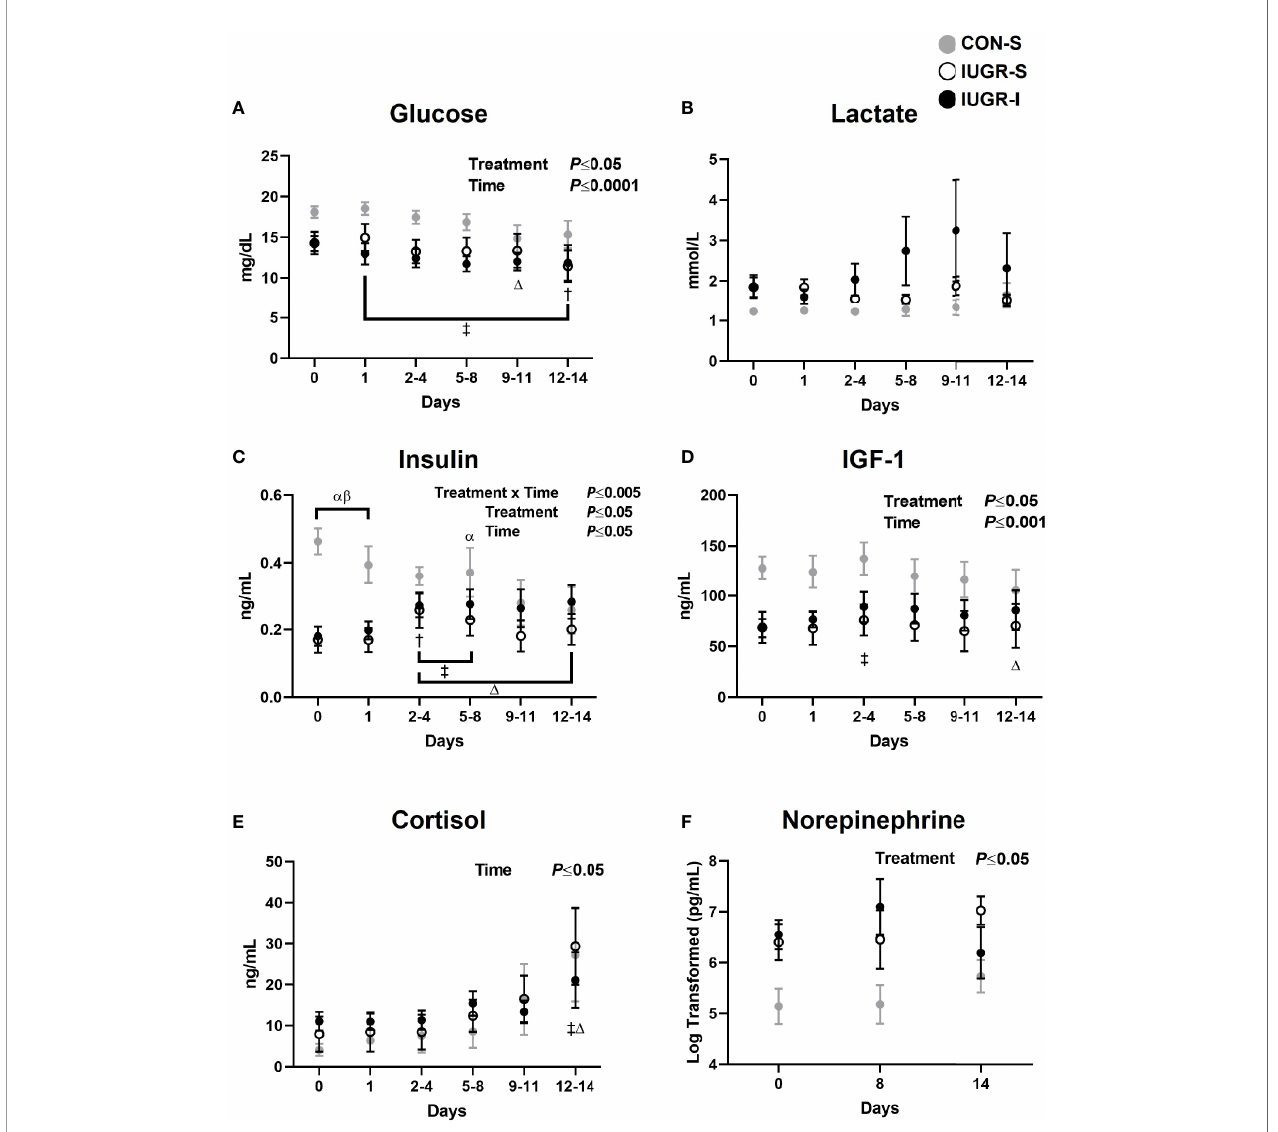
FIGURE 3 | Fetal arterial plasma hormone values. Fetal arterial plasma (A) glucose, (B) lactate, (C) insulin, (D) IGF-1, (E) cortisol, and (F) norepinephrine values during insulin or saline infusions. CON-S (grey circle, n=6), IUGR-S (white circle, n=7), and IUGR-I (black circle, n=11). Values are mean ± SEM. Statistical signi fi cance was designated at P ≤ 0.05 by two-way ANOVA to determine the effects of treatment (CON-S, IUGR-S, IUGR-I), time (day of infusion), and interaction. Fisher ’ s least signi fi cant difference post hoc test was indicated by the following: a , IUGR-S vs . CON-S; b , IUGR-I vs . CON-S; D , CON-S vs . baseline; † , IUGR-S vs . baseline; and ‡ , IUGR-I vs . baseline. Data for norepinephrine were log-transformed for